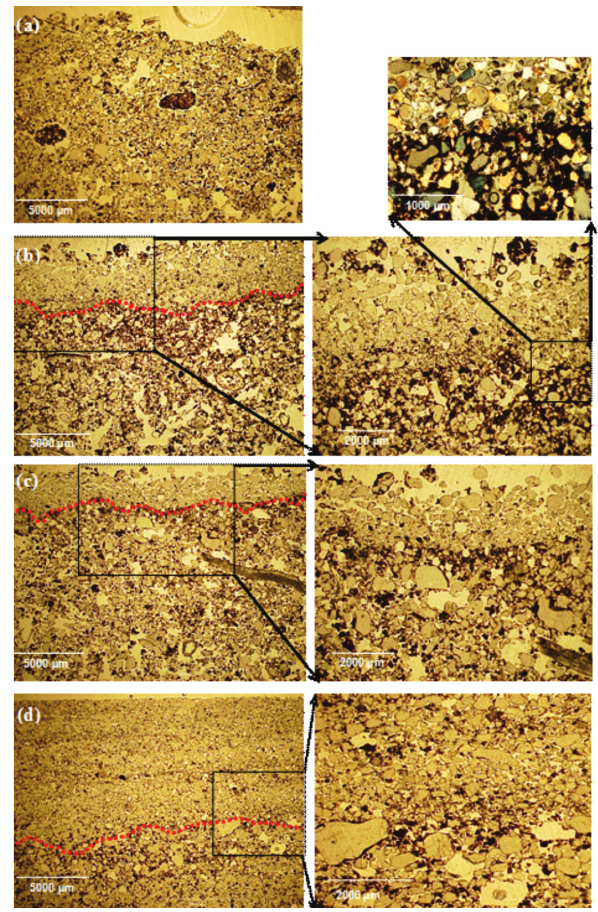
Figura 1. Detalhes da crosta formada no PC em razão das lâminas de chuva aplicada sobre um Argissolo Vermelho-Amarelo (Piracicaba, SP). (a), (b), (c) e (d) correspondem a 0, 27, 54 e 80 mm,